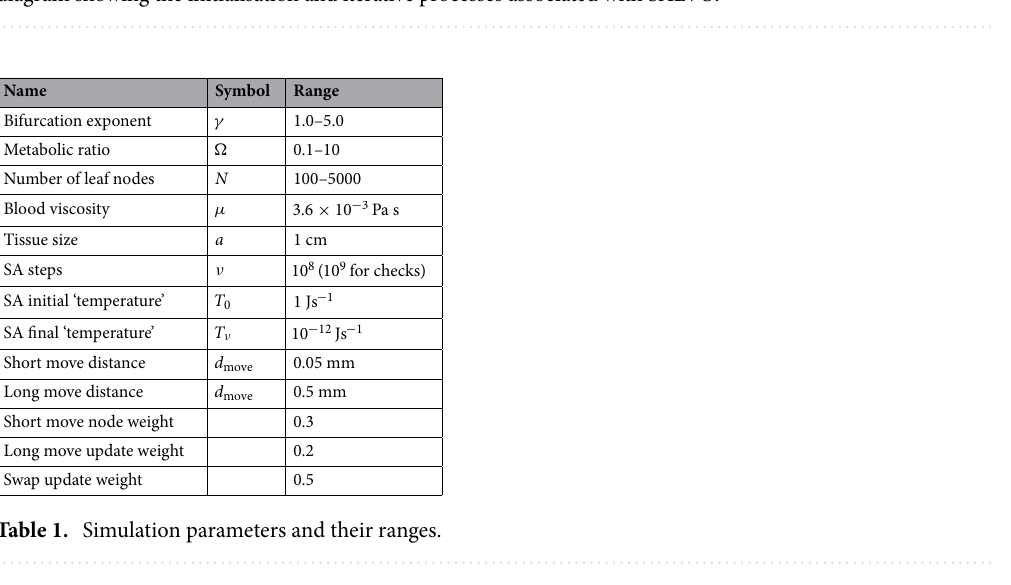
Figure 2. Schematic of the algorithm, showing the two types of update and a flow diagram of the SALVO process. ( a ) and ( b ): Two types of update are required for ergodicity, that ( a ) move node coordinates and ( b ) swap the parent segments of nodes. The figure shows a summary of these updates. In panel ( a ) node a is moved. In panel ( b ) parents of two nodes (nodes b and d) are swapped. The parent of node b is node a, and the parent of node d is node c. After the swap, the parent of node b is node c and the parent of node d is node a. ( c ) Flow diagram showing the initialisation and iterative processes associated with SALVO.